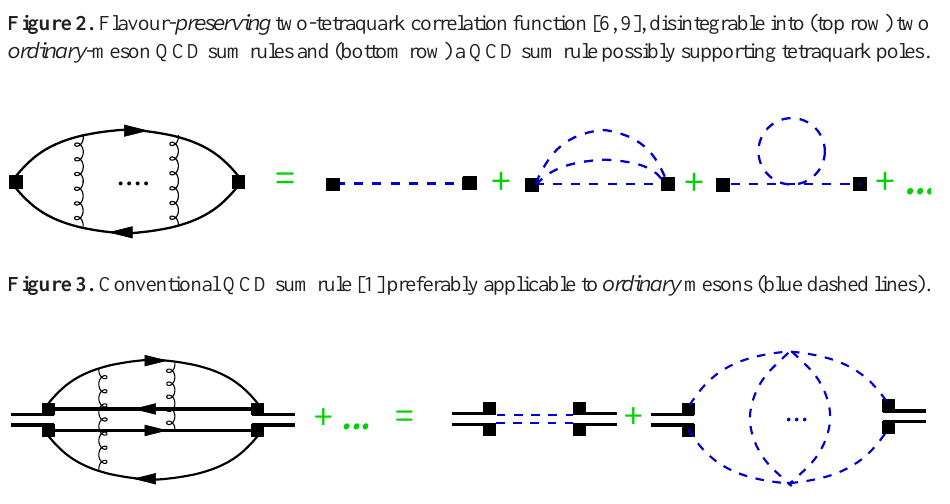
Figure 4. Refined QCD sum rule [6] likely improving analyses of tetraquarks (blue dashed double line).